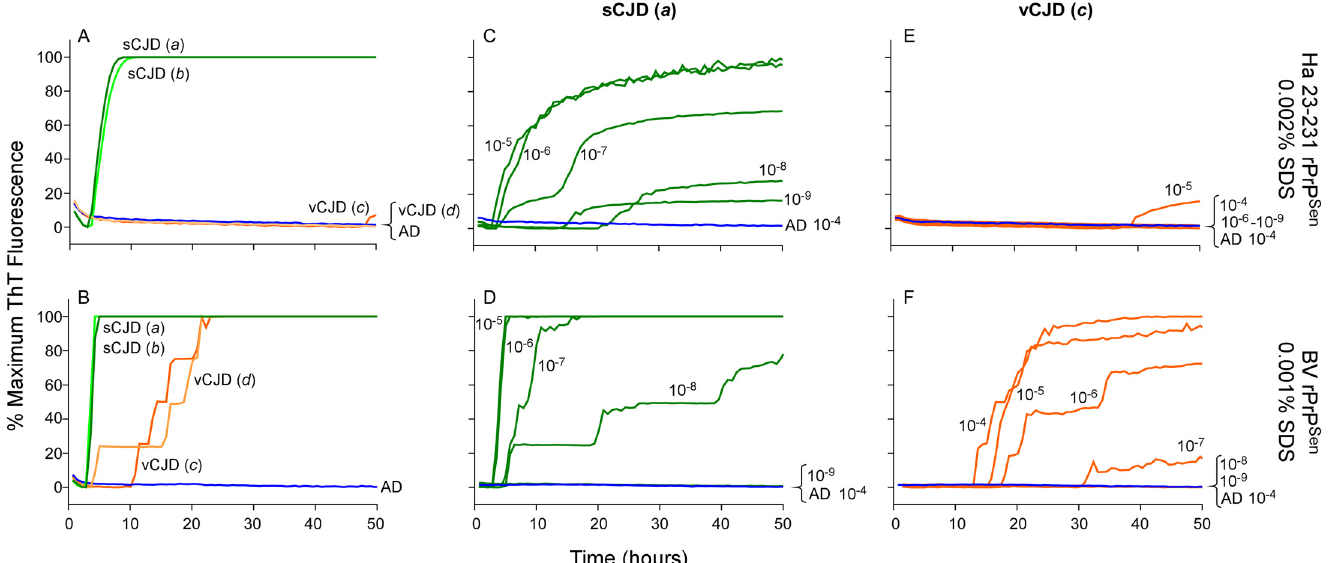
Fig 9. Detection, discrimination and sensitivities for detection of human sCJD and vCJD with hamster 23 – 231 and BV rPrP Sen substrates. Dilutions (10 -4 ) of frontal cortex brain tissue from two confirmed sCJD (Case a and b , green) and two vCJD cases (Case c and d , orange) were used to seed RT-QuIC reactions. Testing was performed using either hamster (23 – 231) in the presence of 300mM NaCl and 0.002% SDS (A) or BV PrP Sen in the presence of 300mM NaCl and 0.001%SDS (B). Brain homogenates from one sCJD (Case a ) and one vCJD (Case c ) patient were serially diluted (10 -5 to 10 -8 ) for RT-QuIC analysis. Hamster 23 – 231 (C and E) and BV rPrP Sen (D and F) were used as a substrate. These samples were tested in three independent experiments with similar results. Traces represent the averages of four replicate wells.